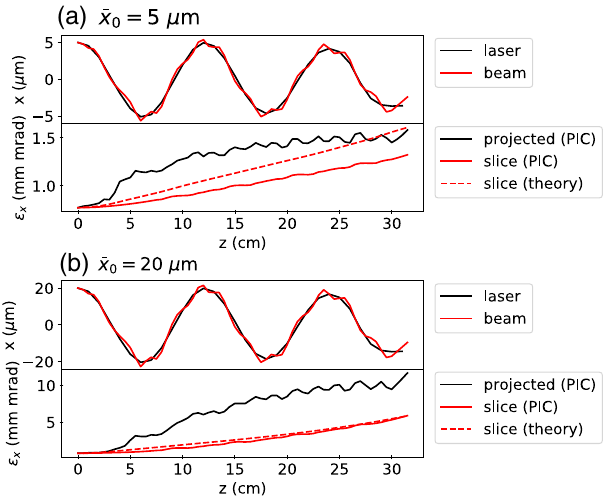
FIG. 6. Emittance growth along propagation due to laser pulse misalignment. (a) The top panel shows the transverse position of the laser pulse (black line) and electron beam (red line). The initial pulse offset is ¯ x 0 ¼ 5 μ m, and the electron beam starts with X ¼ ¯ x 0 0 . The electron beam follows the laser centroid oscilla- tions. The bottom panel shows the projected and slice emittance along with the theory for slice emittance. (b) shows the same quantities for ¯ x 0 ¼ X 0 ¼ 20 μ m.